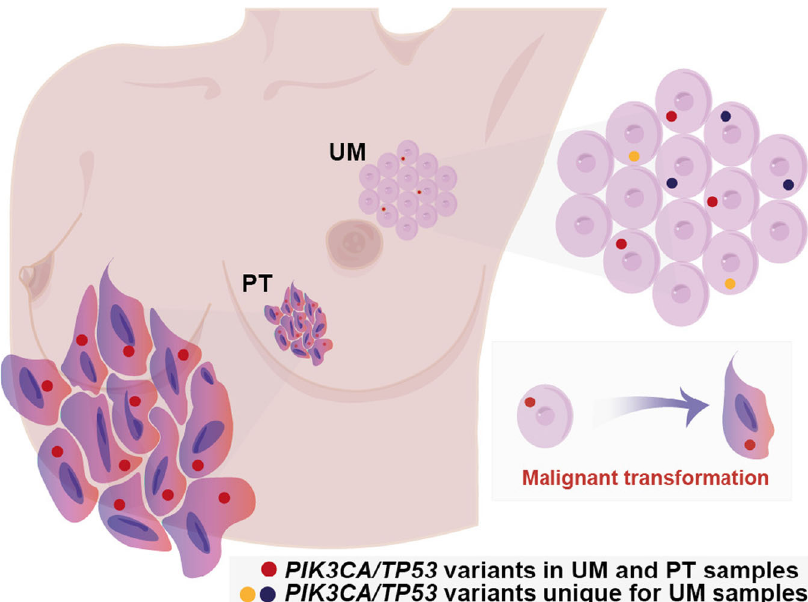
Fig. 4 Oncogenic potential of the normal mammary tissue. We used duplex sequencing to screen for ultra-low frequency variants and detected PIK3CA and TP53 hotspot alterations. The sampled normal mammary gland tissue is referred to as uninvolved glandular tissue and was not removed during surgical resection of the tumor mass. Detected variants might alter the function of the main breast cancer drivers: activate PIK3CA oncogene and impair TP53 tumor suppressor DNA-binding capacity. The presence of these changes implicates an oncogenic potential of the uninvolved mammary gland tissue and emphasizes the importance of thorough monitoring of sporadic breast cancer patients that underwent breast-conserving